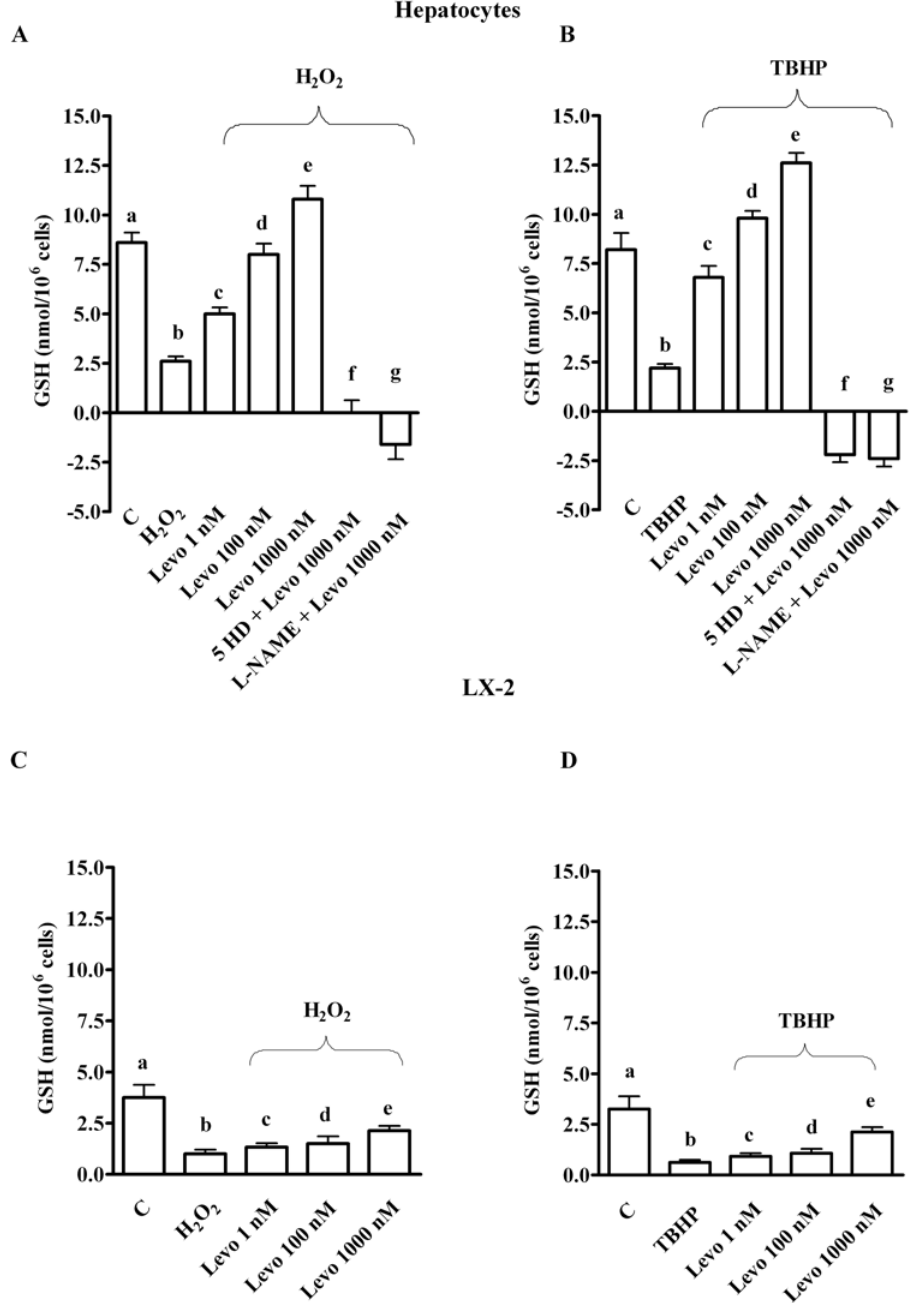
Fig 3. Effects of levosimendan on glutathione content in hepatocytes and LX-2. In A and B, b, c, e, f, g P < 0.05 vs a; c, d, e, f, g P < 0.05 vs b; d, e P < 0.05 vs c; d, f, g P < 0.05 vs e. In C and D, b, c, d P < 0.05 vs a; e P < 0.05 vs b. In D, e P < 0.05 vs c, d. GSH = glutathione. Other abbreviations are as in Figs 1 and 2. The results obtained in hepatocytes and LX-2 are expressed as means of 5 or 4 independent experiments (%) ± SD (indicated by the bars), respectively.